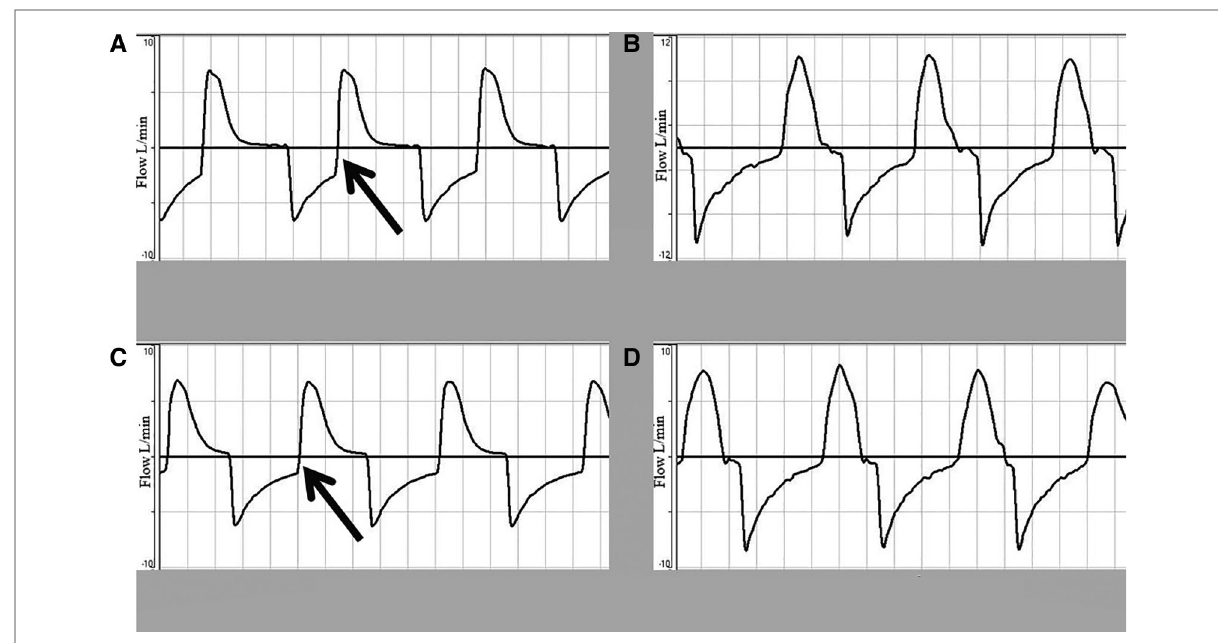
FIGURE 4 Flow-time waveform showing incomplete exhalation due to rapid cycling to inhalation at PIP of 30 cmH 2 O and 60 in fl ations per minute. ( A,C ) Depict the fl ow-time waveform before and after the saline wash using a TPR. ( B,D ) Show the fl ow-time waveform before and after the saline wash using a